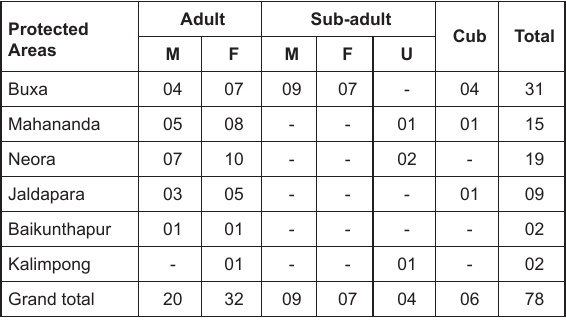
Table 4. Population composition of tiger in northern West Bengal during 2002 (Anon.